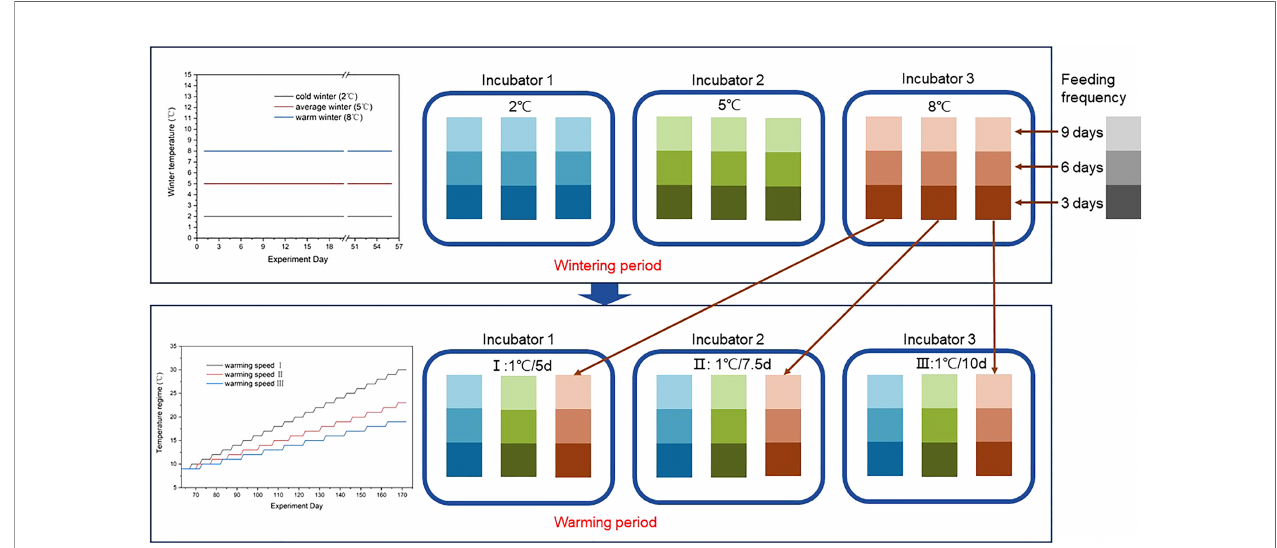
FIGURE 1 | Experimental design. These polyps were fi rst stored at 3 winter temperatures (2°C, 5°C, and 8°C) for 8 weeks, and then experienced the culture of 3 warming speeds (1°C increment every 5 days, 7.5 days, and 10 days). During the whole experiment, the polyps were fed with adequate Artemia nauplii under 3 feeding frequencies (once per 9 days, once per 6 days, and once per 3